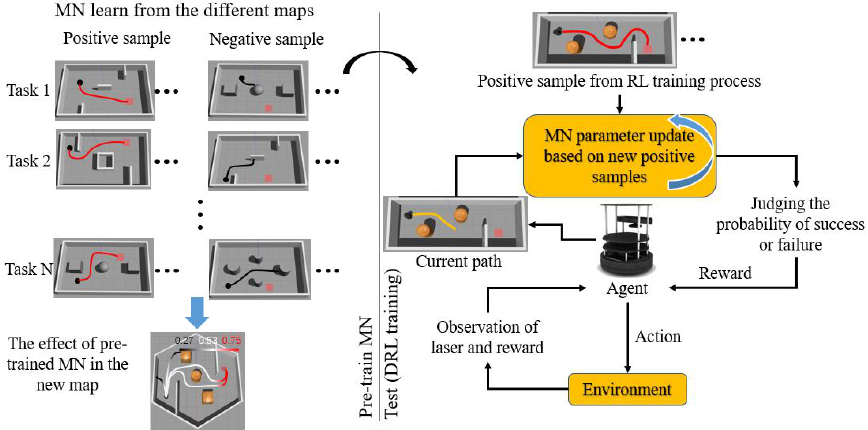
Figure 1. Our model flowchart.